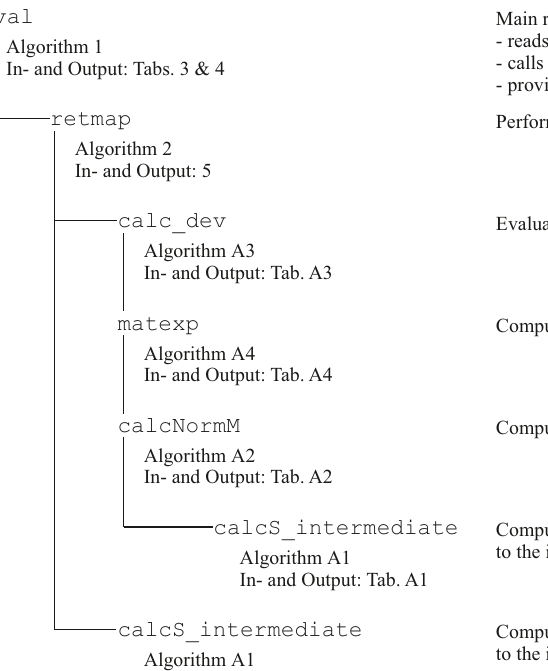
Algorithm 1 In- and Output: Tabs. 3 & 4